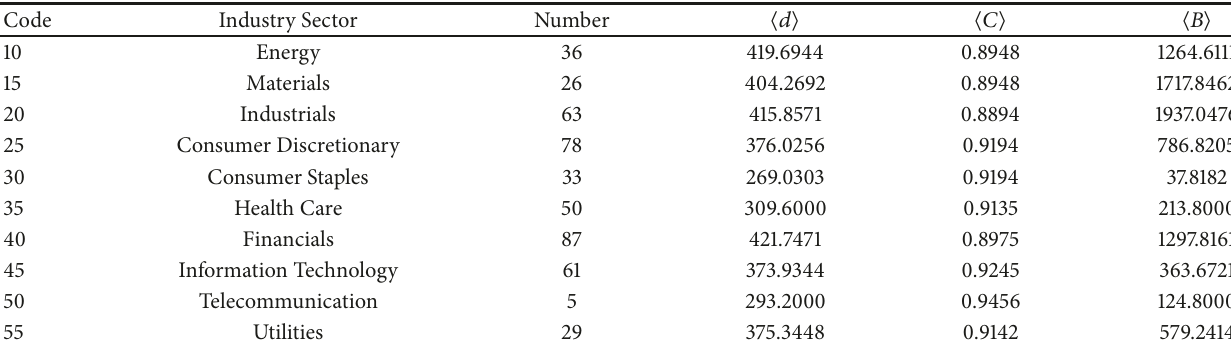
Table 7: In this table, we list the industry code, the sector name, the numbers of stocks, the average degree ⟨𝑑⟩ , the average clustering coefficient ⟨𝐶⟩ , and the average betweenness coefficient ⟨𝐵⟩ for each industry sector of S&P468 stocks. The values are calculated for the S&P468 network with 𝜃 = 1.0 .